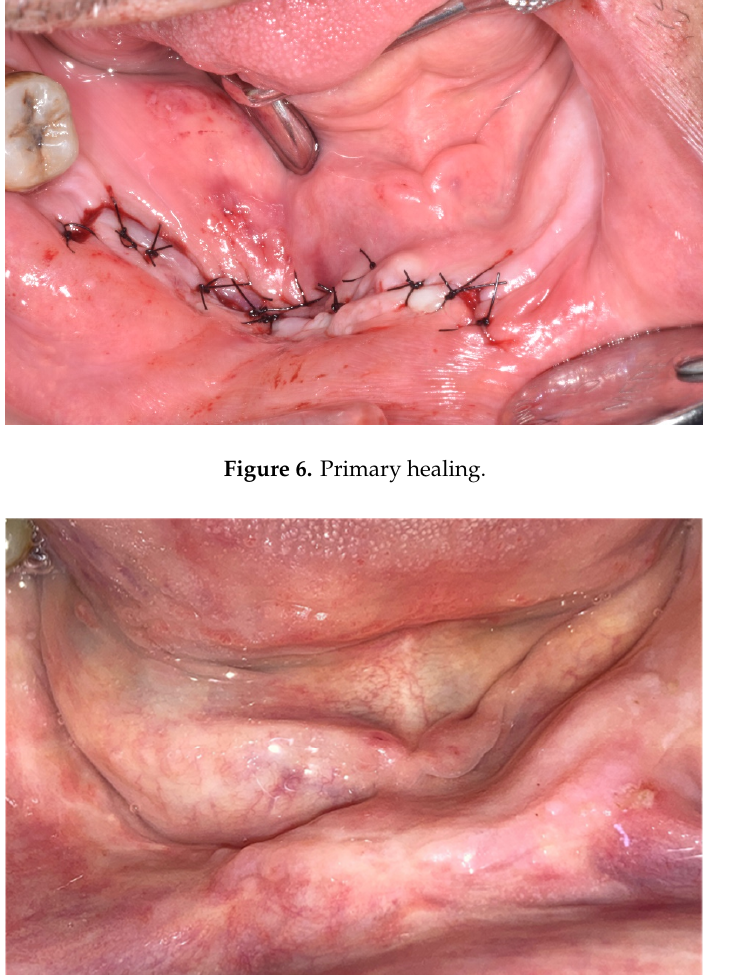
Figure 7. One-month follow-up.